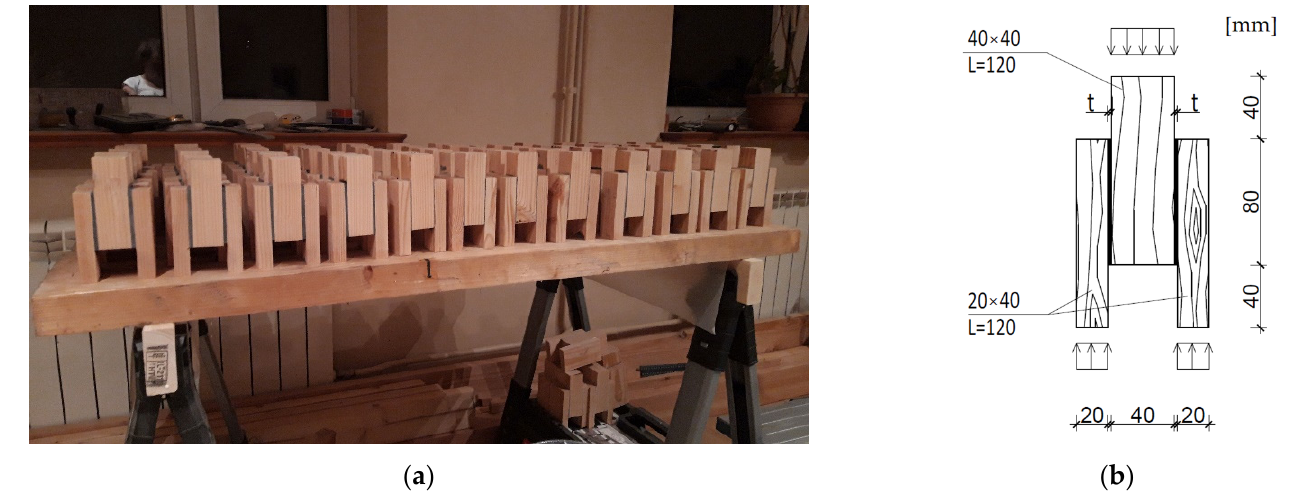
Figure 2. Double lap joint: ( a ) prepared specimens; ( b ) specimen dimensions, where: t—adhesive layer thickness.